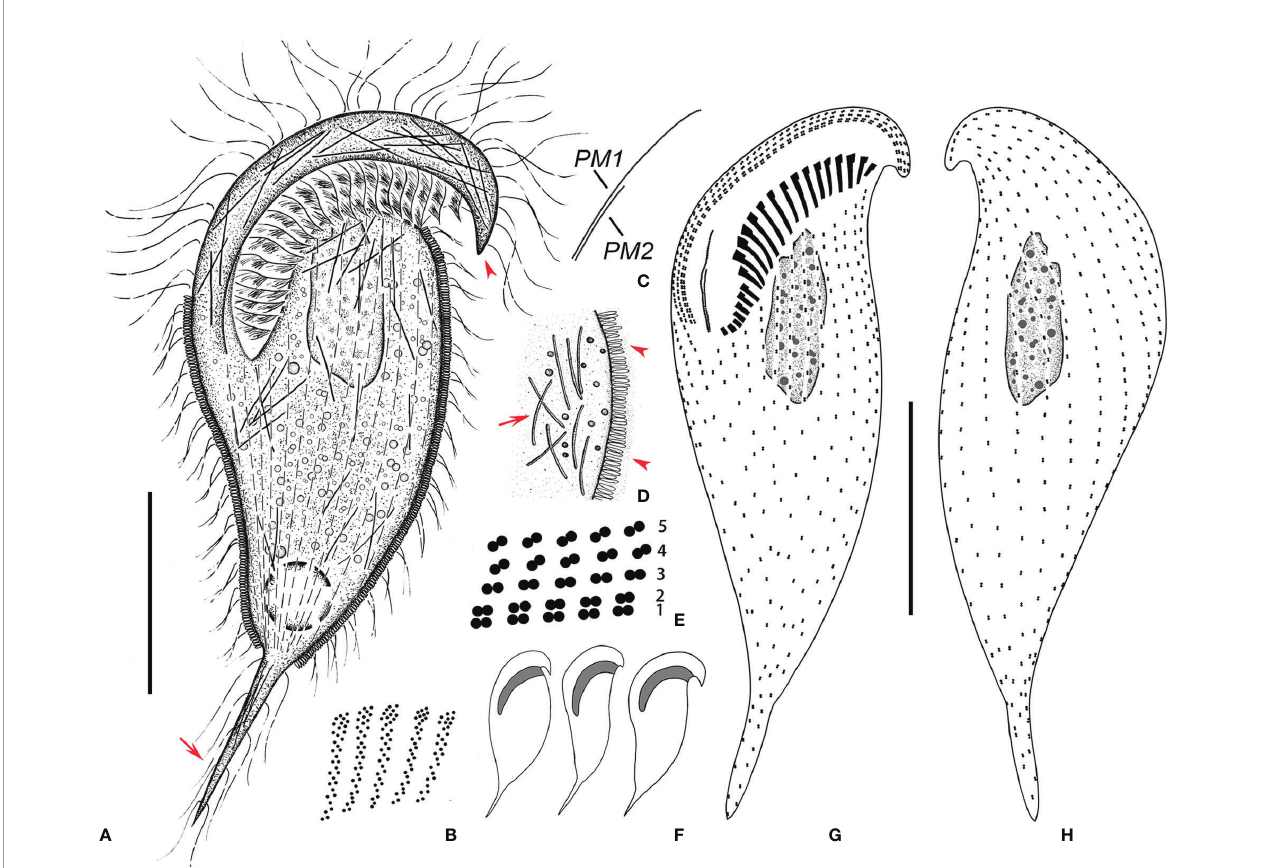
FIGURE 4 | Metopus spiculatus sp. n. from life (A, D, F) and after protargol staining (B, C, E, G, H) . (A) Ventral view of a representative specimen, showing body shape, ectosymbionts, contractile vacuole, beak-like preoral dome end (arrowhead), and posterior tail (arrow). (B) Structure of membranelles from the mid-portion of the adoral zone. (C) Two paroral membranes. (D) Ectosymbionts (arrowheads) and needle like structures (arrow). (E) Part of the perizonal stripe and false kineties. (F) Different body shapes. (G, H) Ventral (G) and dorsal (H) view of the holotype showing perizonal stripe, dome kineties, paroral membranes, adoral membranelles, and somatic kineties. PM, paroral membrane. Scale bars, 30 m